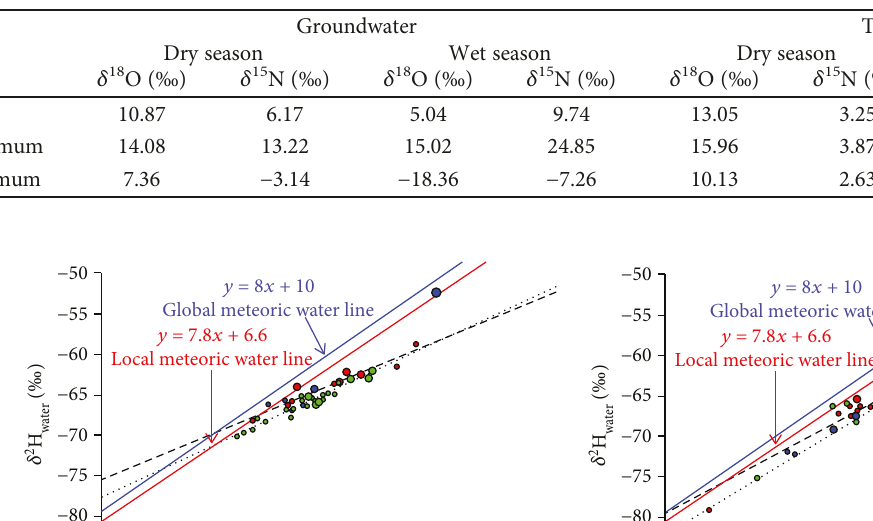
Table 5: Statistical summary of δ 18 O